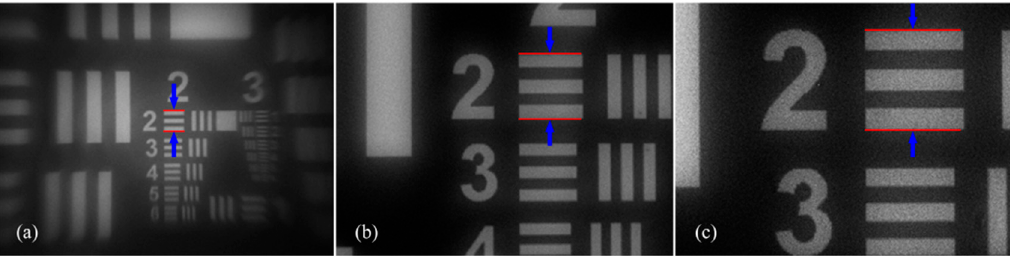
Figure 10. Images captured in different EFL. ( a ) wide end, when I 2 = 5 mA, 18 pixels between two red lines; ( b ) middle phase, when I 2 = 60 mA, 59 pixels between two red lines; ( c ) tele end, when I 2 = 100 mA, 91 pixels between two red lines.